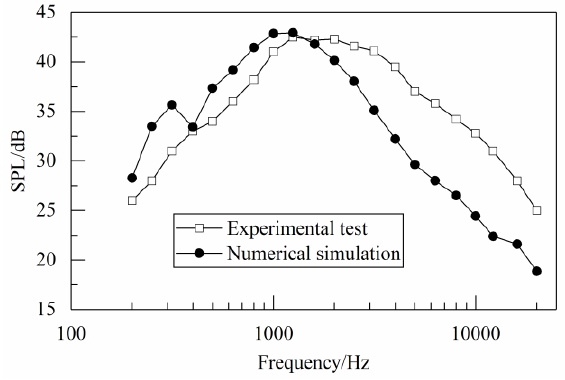
Figure 9. Results of the flow-induced noise validation. SPL: sound pressure level.